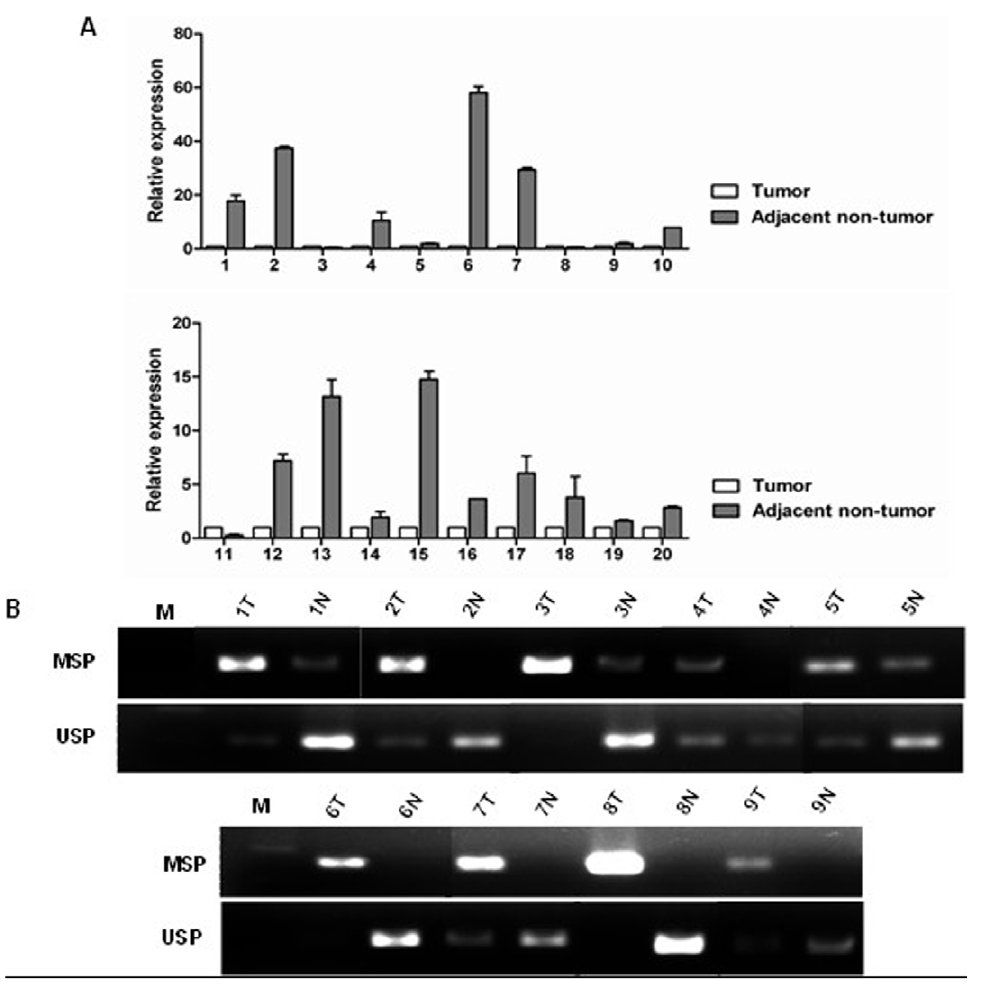
Figure 3. FBP1 gene was downregulated and hypermethylated in primary tumor tissues. ( A ) The expression of FBP1 in liver, gastric and colon tumor tissues and adjacent non-tumor tissues were determined by Real-Time RT-PCR. 1 , 10 T/N: liver cancer, 11–15 T/N: gastric cancer, 16 , 20 T/N: colon cancer. ( B ) The methylation status of FBP1 promoter in primary liver, gastric and colon tumor tissues and adjacent non-tumor tissues was detected by MSP. Representative results were shown. 1 , 3 T/N: liver cancer, 4 , 5 T/N: colon cancer, 6 , 9 T/N: gastric cancer. ‘‘T’’ indicates tumor tissues and ‘‘N’’ represents adjacent non-tumor tissues.